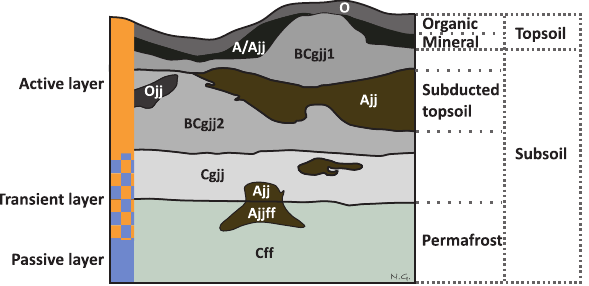
Figure 2. Overview of the soil diagnostic terminology used in this study. Horizon nomenclature according to Keys to Soil Taxonomy (Soil Survey Staff,